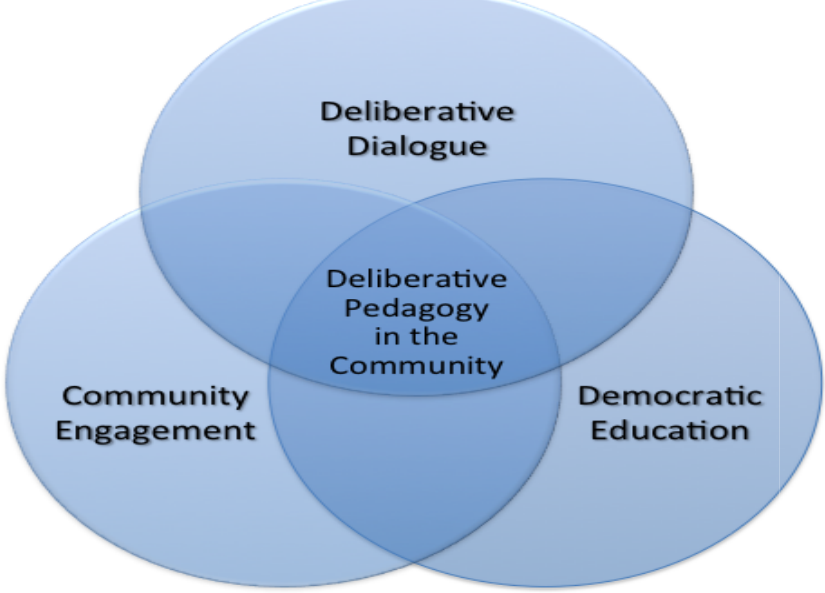
Figure One: Deliberative Pedagogy in the Community